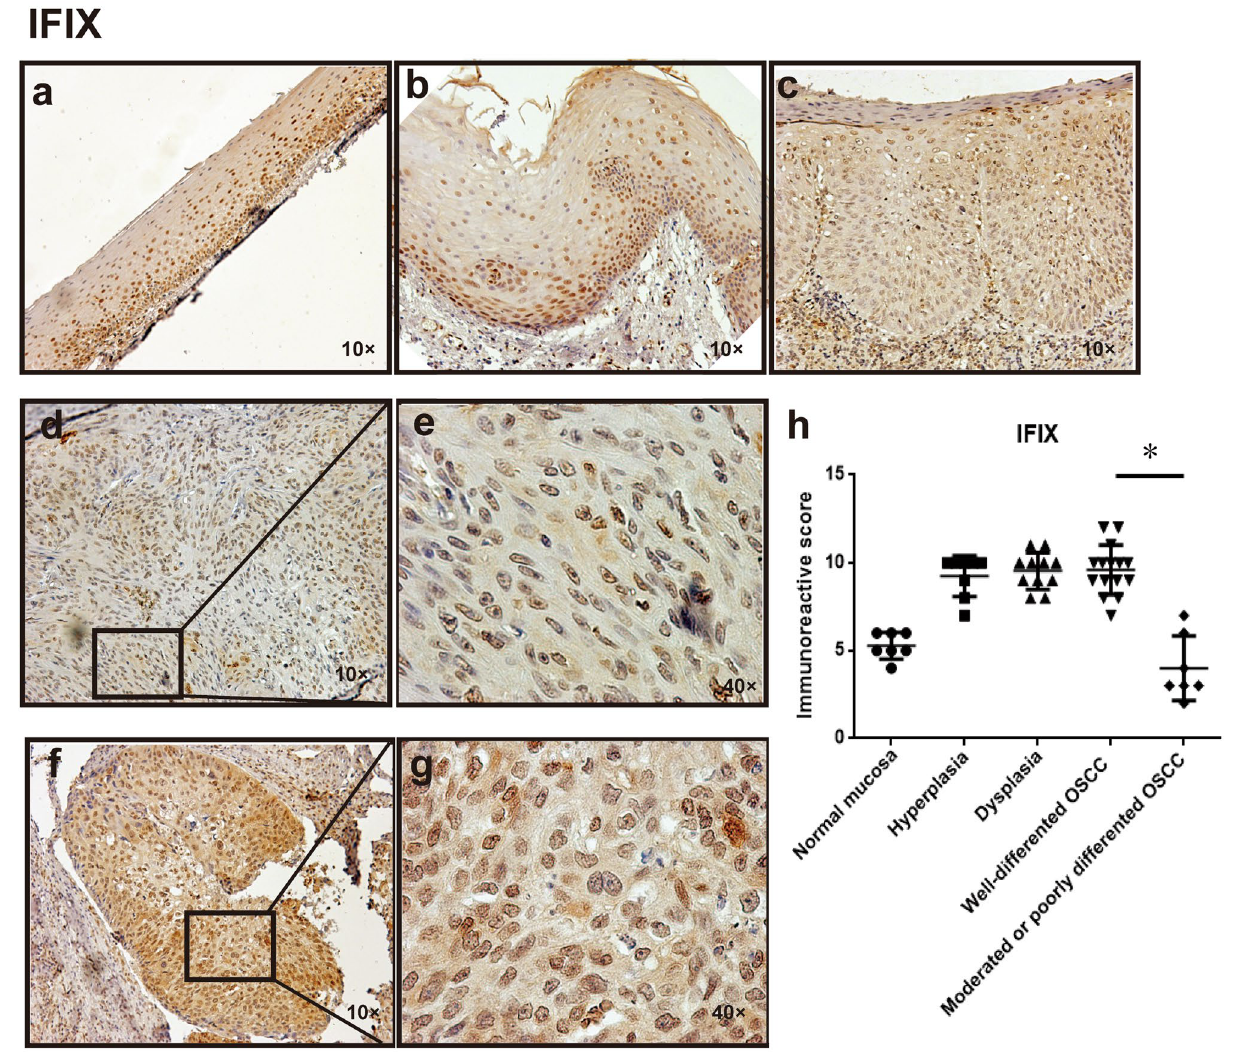
Figure 1. Characteristic IFIX expression in OSCC and its precursor stages. ( a – c ) IFIX expression by IHC in histopathologically assessed normal mucosa, hyperplasia, and dysplasia. ( d , e ) Lower expression of IFIX in moderately differentiated OSCC. ( f , g ) Higher expression of IFIX in well-differentiated OSCC cells. ( h ) The pattern of immunoreactive scores of IFIX staining in cancer tissue samples of OSCC at various histopathological grades and OSCC precursor